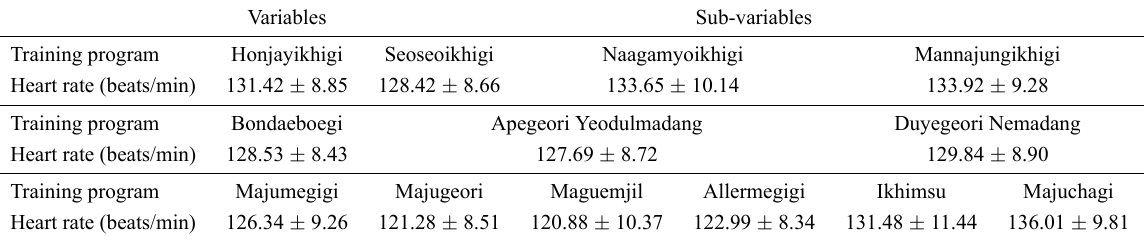
Table 3. Heart rate (exercise intensity) in the training